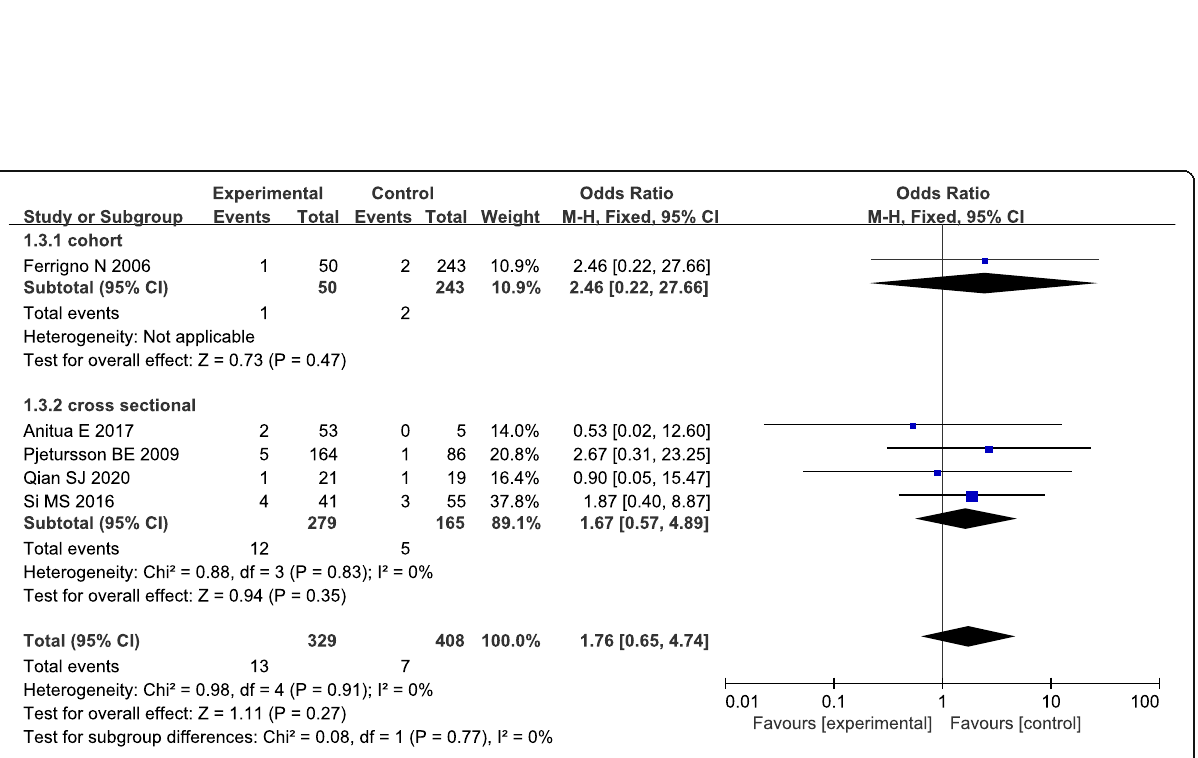
Fig. 4 Forest plot of the 3-year survival rate between short implants combined with TSFE (experimental group) and conventional implants combined with TSFE (control